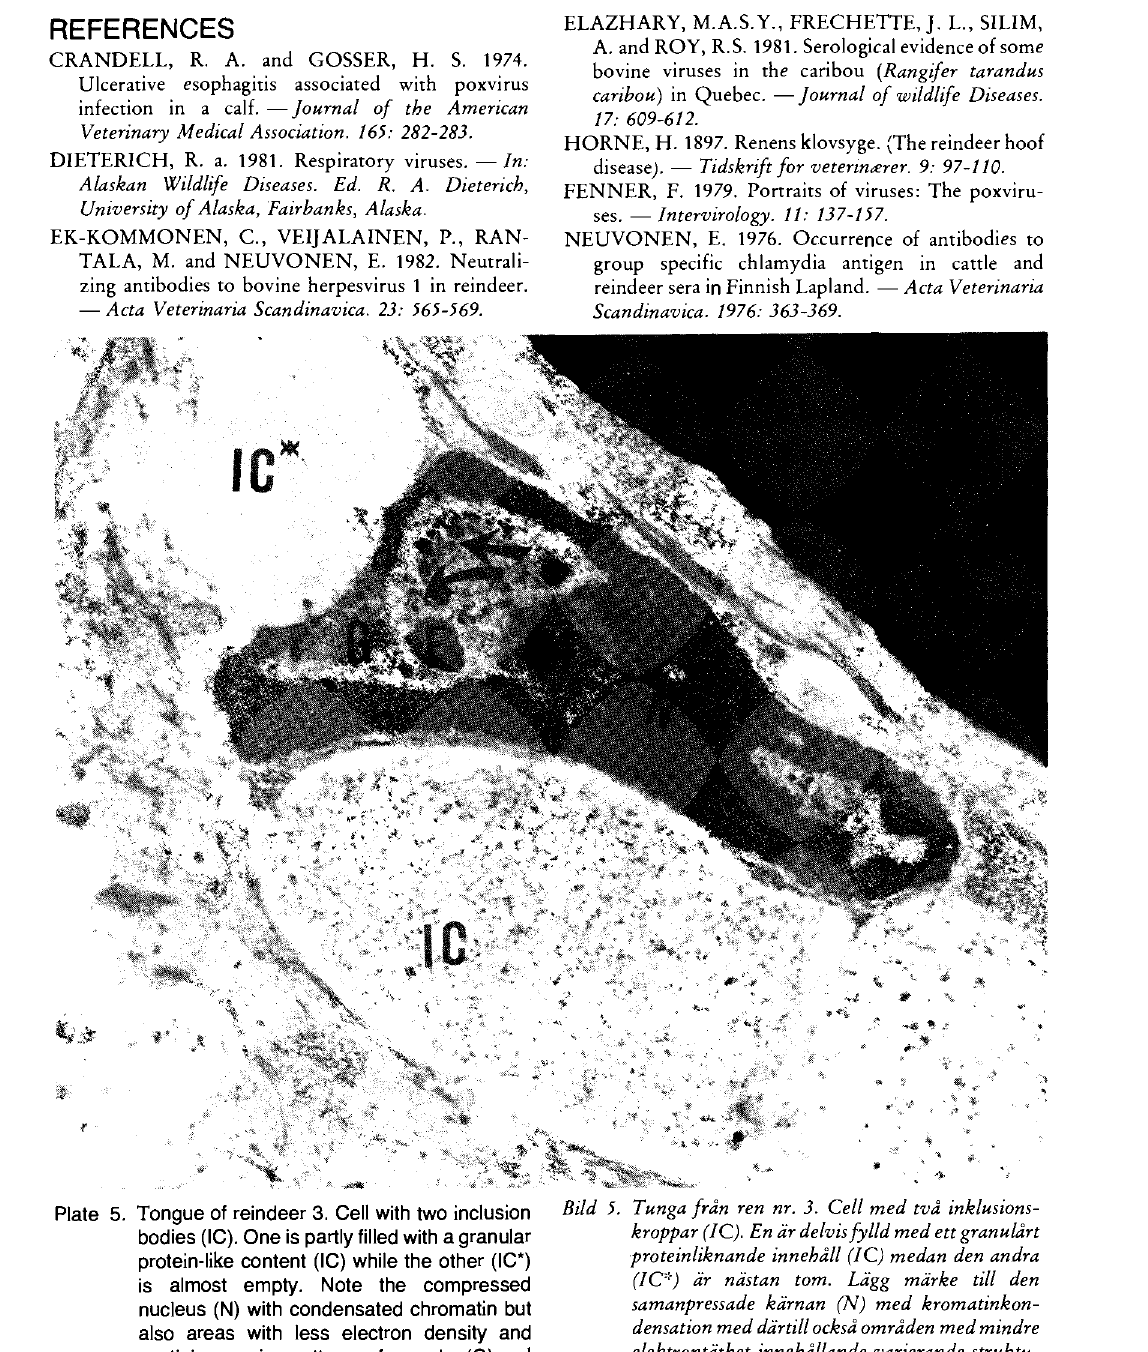
Plate 5. Tongue of reindeer 3. Cell with two inclusion bodies (IC). One is partly filled with a granular protein-like content (IC) while the other (IC*) is almost empty. Note the compressed nucleus (N) with condensated chromatin but also areas with less electron density and contining varying patterns of granular (G) and fibrillar components (F). Note also electron dense structures (arrows), x